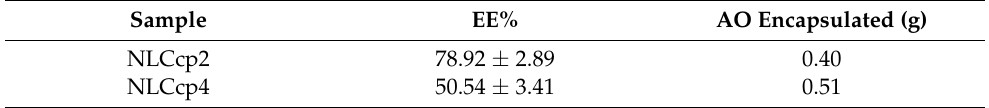
Table 3. Encapsulation efficiency of NLCs based on Cetyl Palmitate.